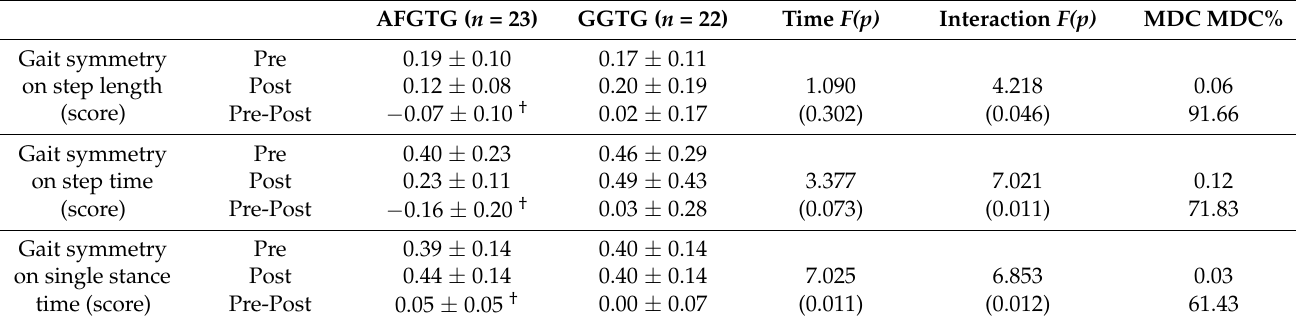
Table 4. Changes in gait symmetry.